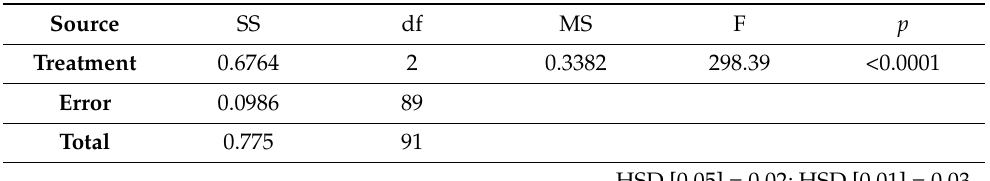
Table 5. ANOVA and Tukey Test for Specificity .